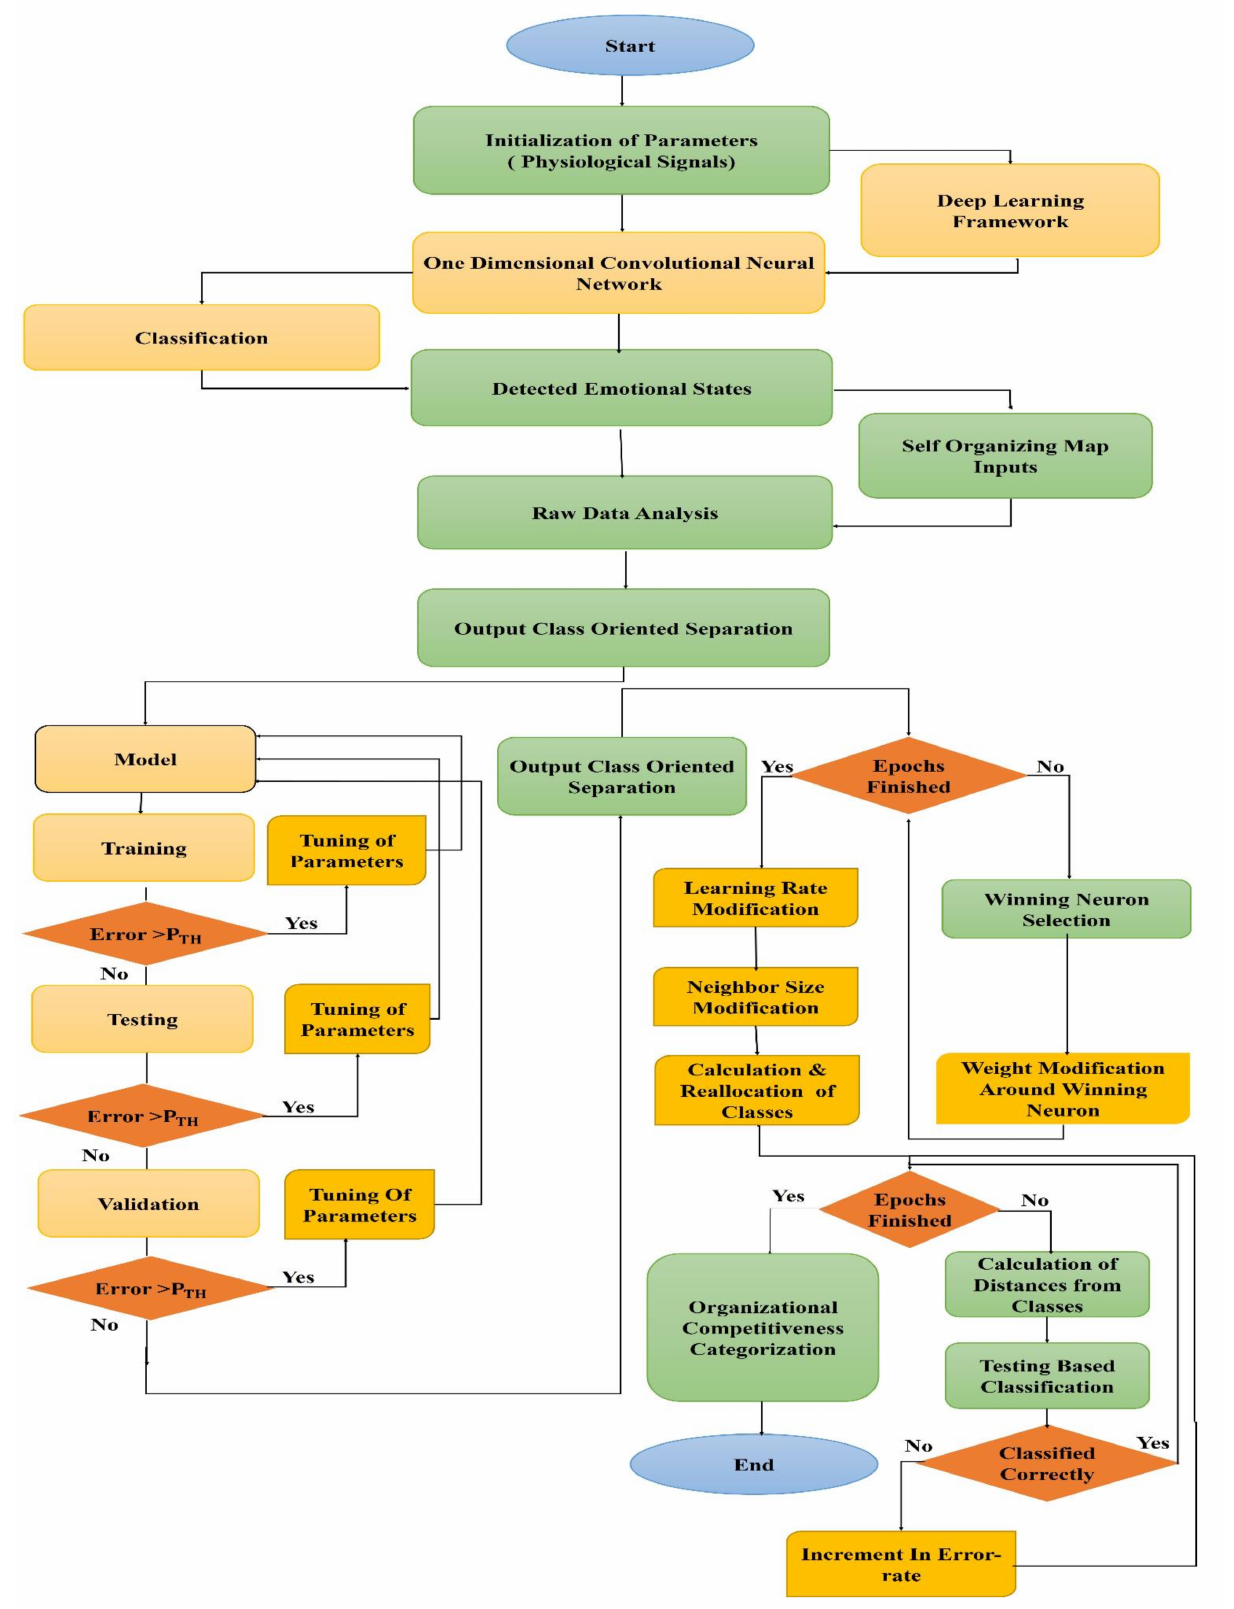
Figure 8. Flow diagram to present the overall